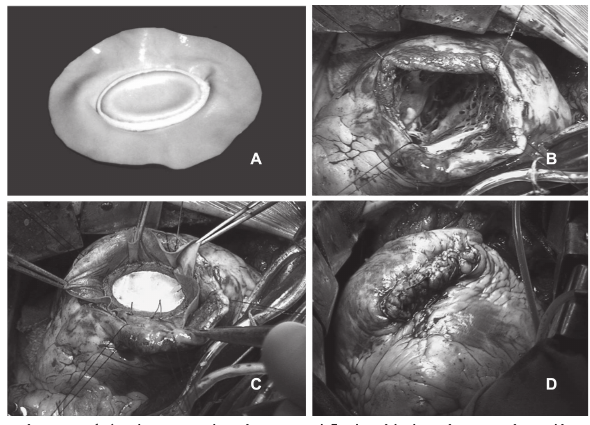
Fig. 1 - (A) The prosthesis assembled with bovine pericardium and a radiopaque ellipsoid ring. (B) Anterior ventriculotomy with an extensive scar at ventricle septum wall. (C) Prosthesis implanted in oblique orientation to the septum. (D) Final aspect of the procedure. (E) Pre-operative oblique anterior angiogram with left ventricle during diastole showing an enlarged cavity Septal Anterior Ventricular Exclusion (SAVE) The initial steps were the same as MD group. The left left anterior interventricular artery. Multiple matress